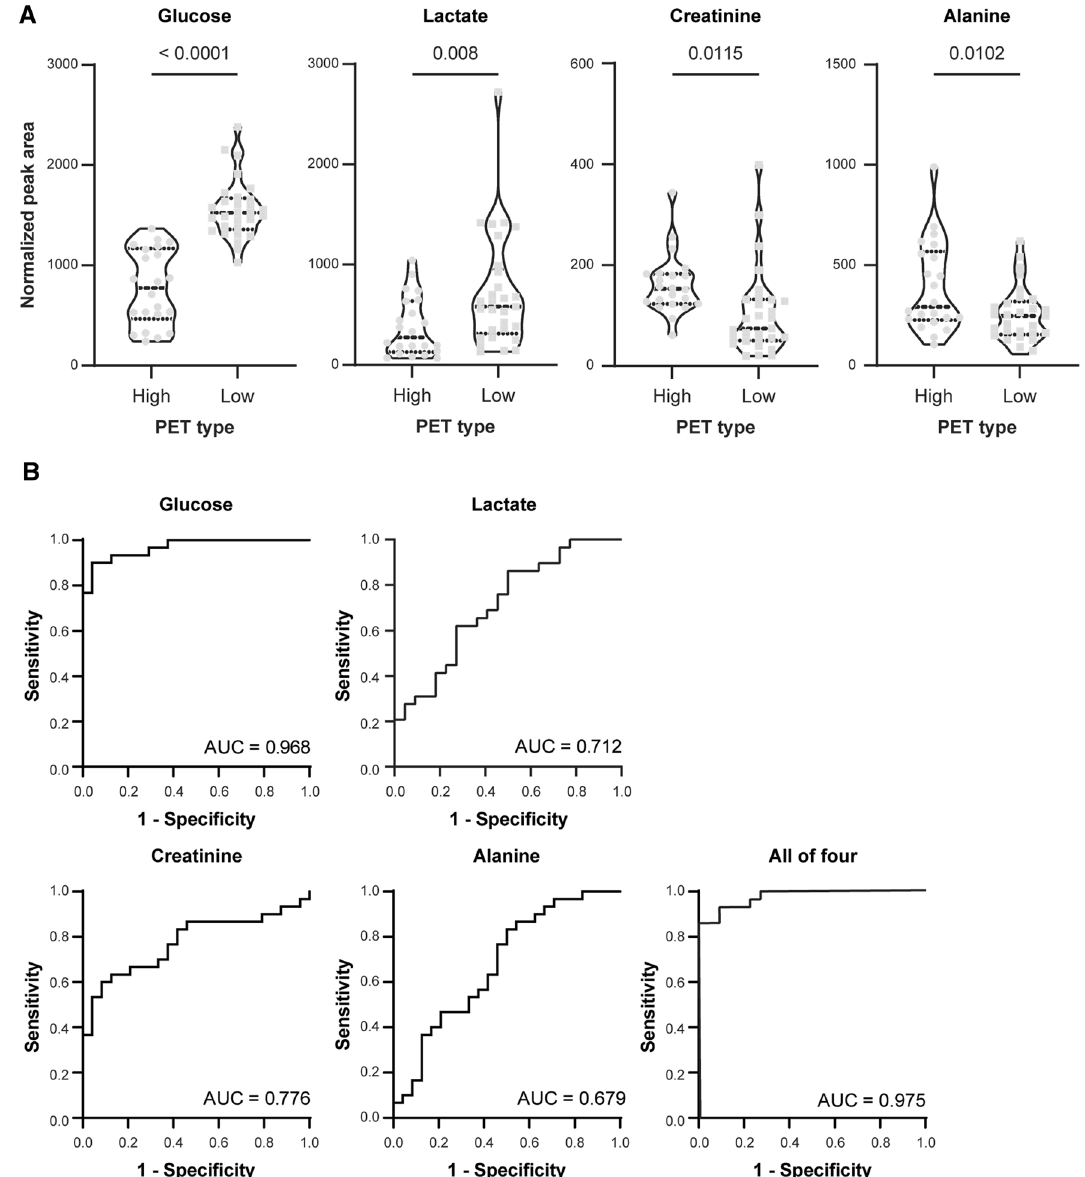
Figure 4. Statistical significance of the markers. ( A ) Levels of markers between the high and low PET types. Violin plots are presented with the median and quartiles. The levels were determined by the mean peak areas normalized by the total area from 1D proton NMR spectra in Fig. 2A. ( B ) PLS-DA-based ROC curves for the diagnosis of high and low PET types with the individual markers–glucose, lactate, creatinine, and alanine and the combination of the 4 markers. Statistical analysis of markers was performed using the Benjamini–Hochberg correction, and the resulting FDR P -values are indicated. PET peritoneal equilibration test, NMR nuclear magnetic resonance, PLS-DA partial least square-discriminant analysis, ROC receiver operating characteristic, AUC area under the curve, FDR false discovery